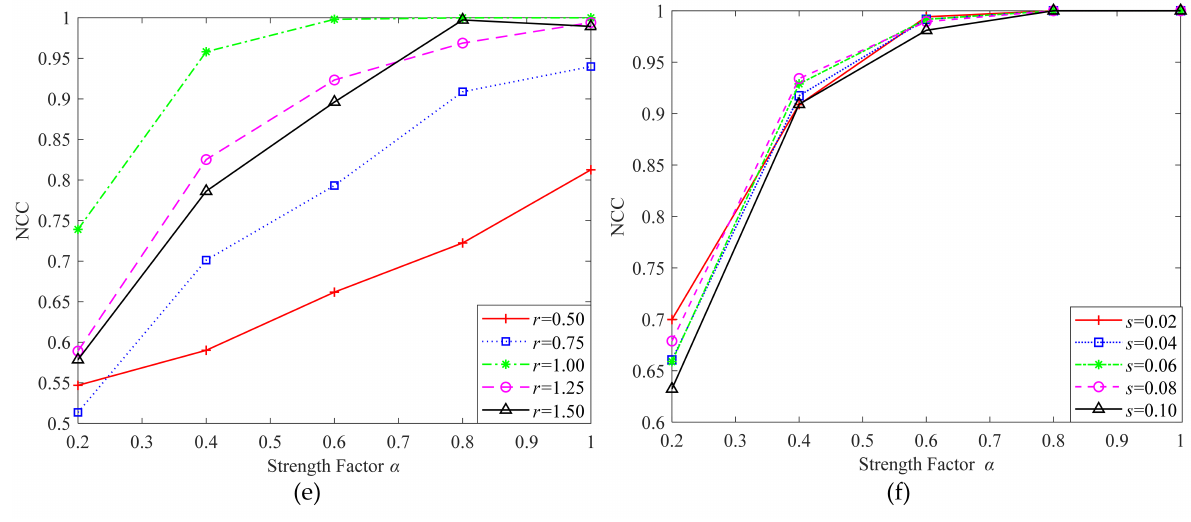
Figure 9. NCC curves under different attacks: ( a ) JPEG compression, ( b ) sharpening, ( c ) cropping, ( d ) Gaussian noise, ( e ) scaling, and ( f ) salt-and-pepper